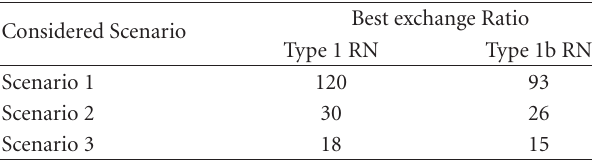
Table 5: Coverage extension evaluation, ISD